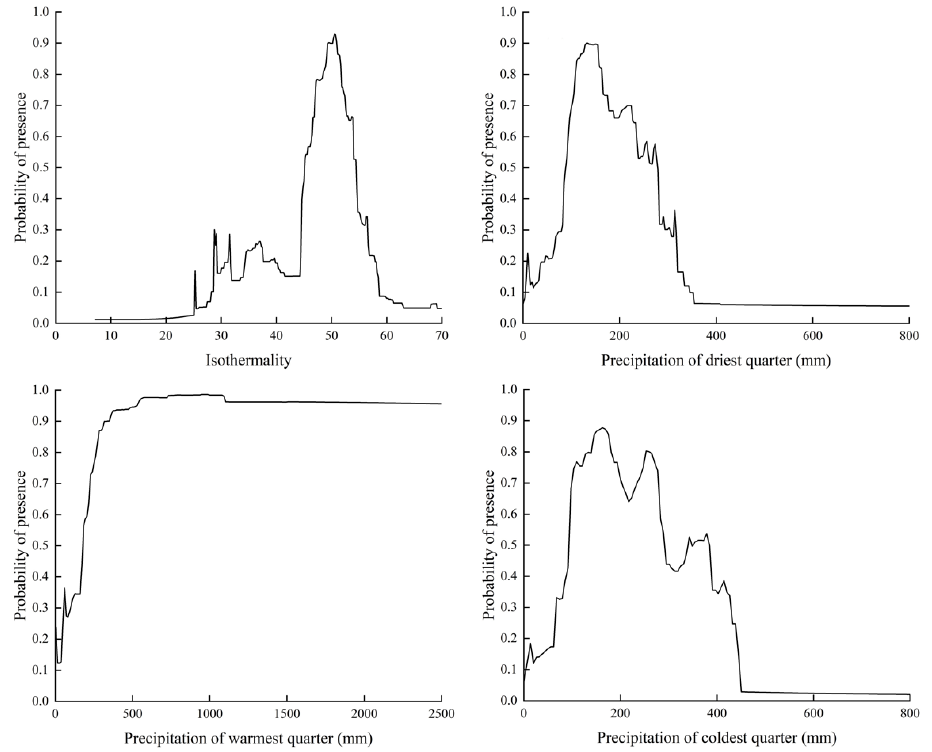
Figure 3. Response curves of presence probability (Bio3, Bio17, Bio18 and Bio19) of Tagetes minuta .